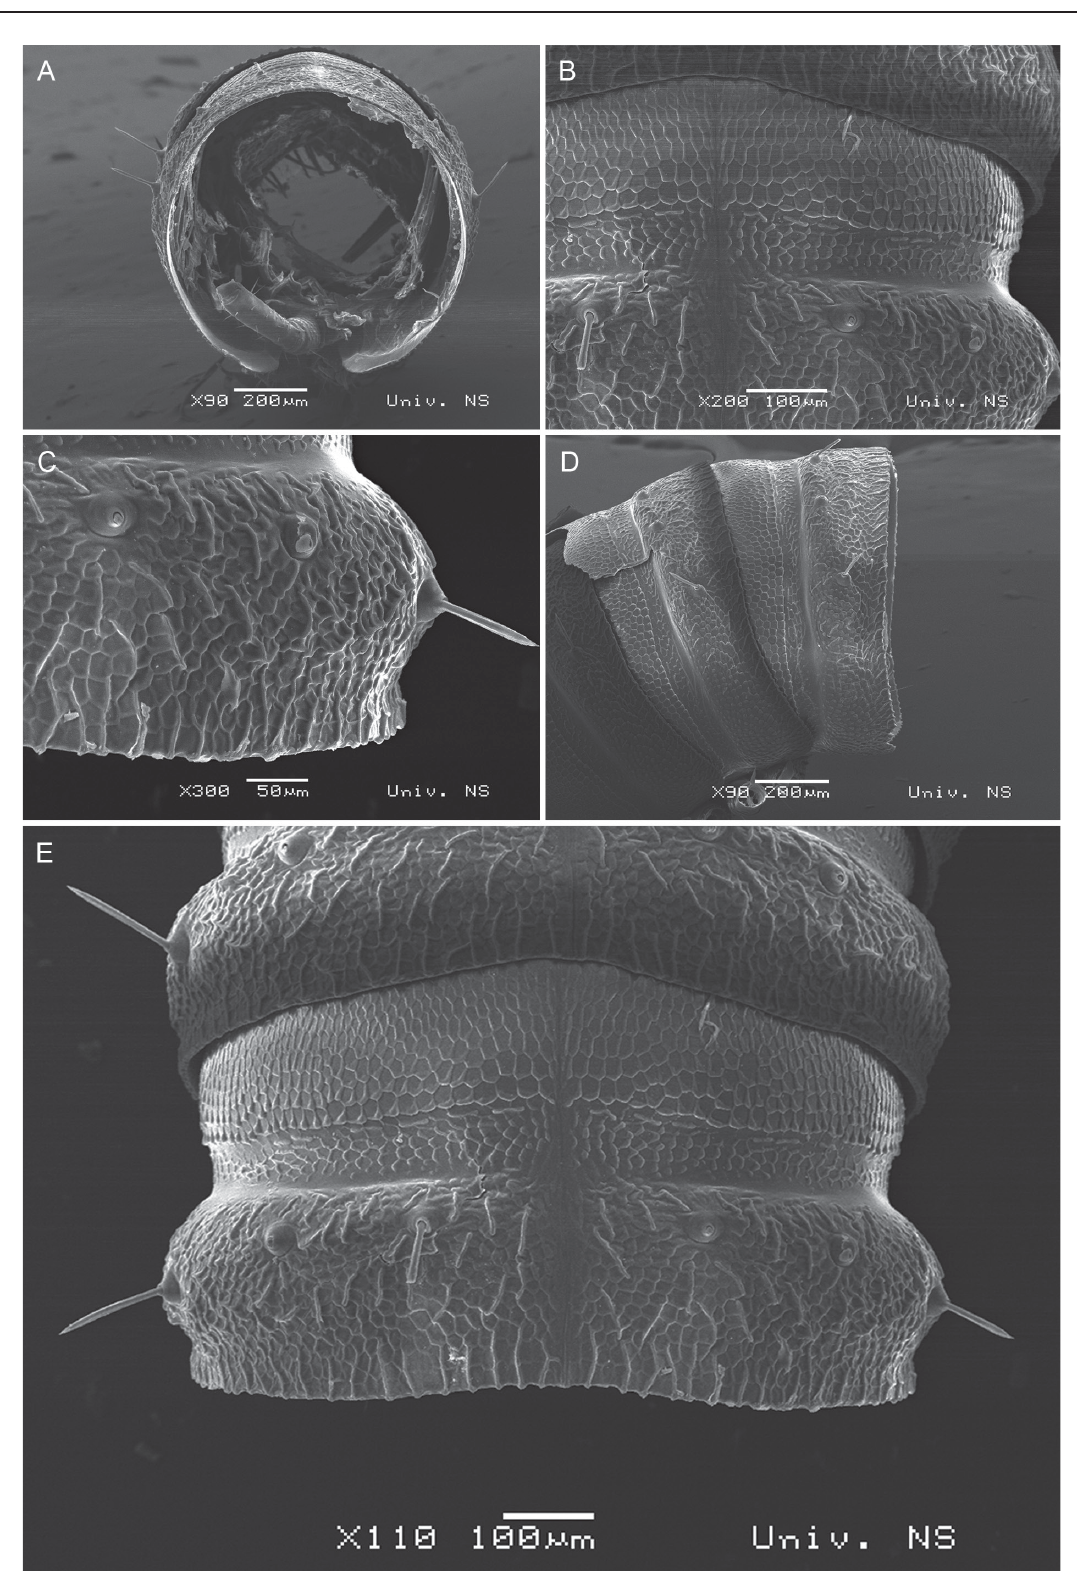
Fig. 4. Biokoviella mosorensis Antić & Dražina sp. nov., ♂, paratype. A . Pleurotergite 15, posterior view. B . Pleurotergite 15, prozonite and metazonite, dorsal view. C . Pleurotergite 15, metaznonite, dorsal view. D . Pleurotergites 14 and 15, lateral view. E . Pleurotergites 14 and 15,